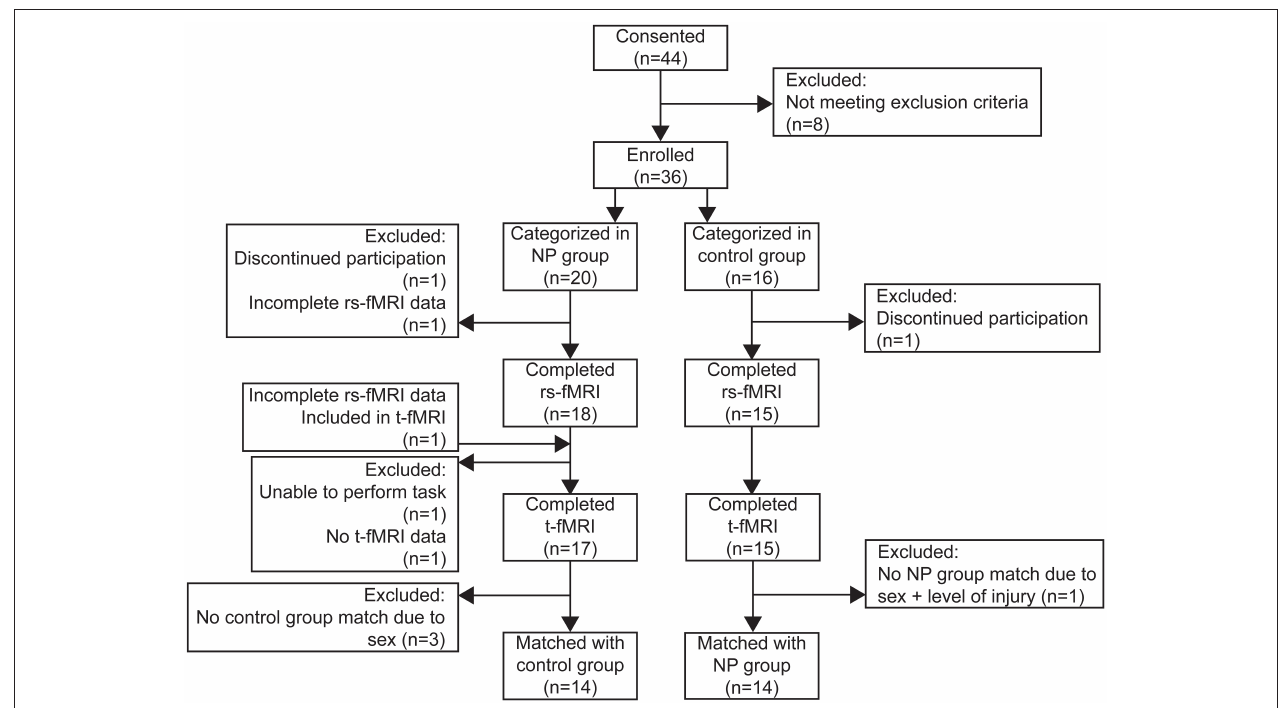
FIGURE 3 | Flow diagram of subjects enrolled and included in resting state connectivity (rs-FMRI) and task-based (t-fMRI) analyses.